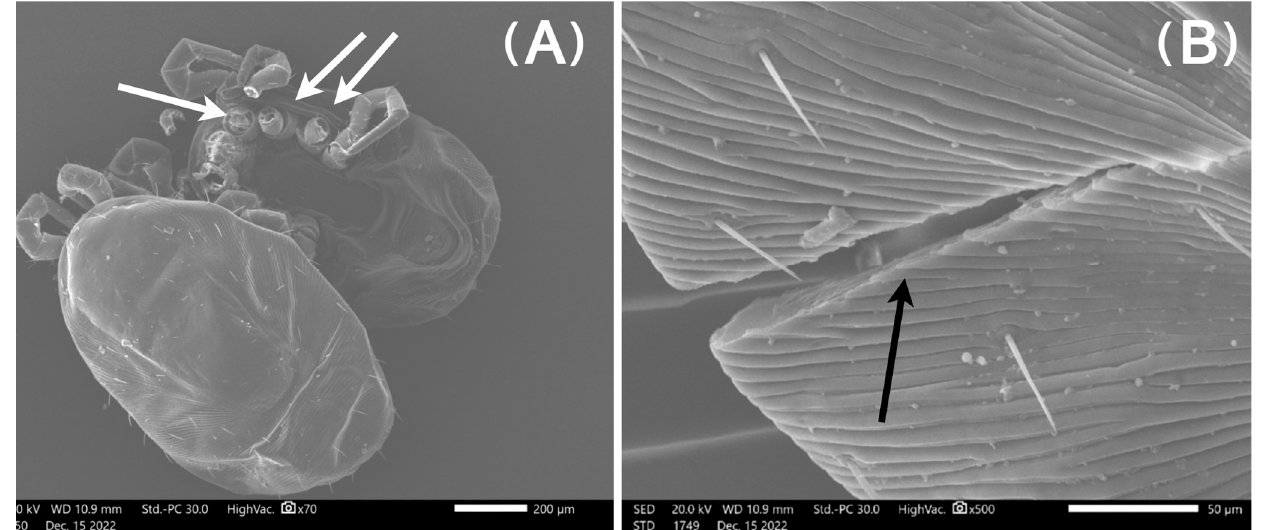
Figure 5. Micrographs of Dermanyssus gallinae after bioassays with AgNPs at 80 ppm for 1 day: ( A ) There are visible leg detachments (white arrows) and ( B ) considerable cracks throughout their exoskeleton (black arrow).